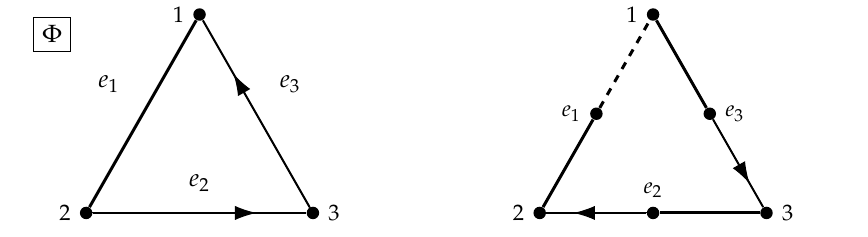
Figure 5. The graph Φ = ( C 3 , ϕ ) and one of its subdivision graphs for an incidence matrix H of Φ